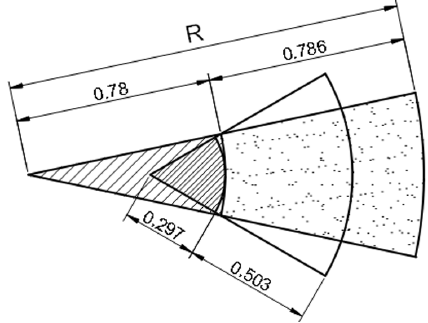
Figure 2. Tributary volumes of the same magnitude and different shapes